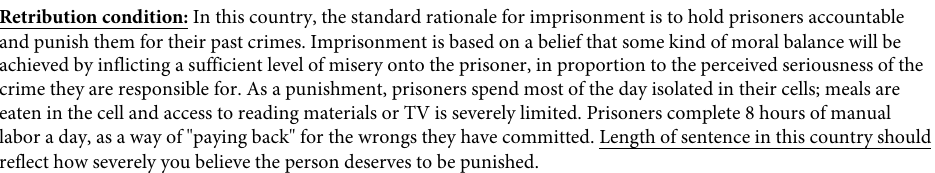
Table 1. Rationales for imprisonment in three hypothetical